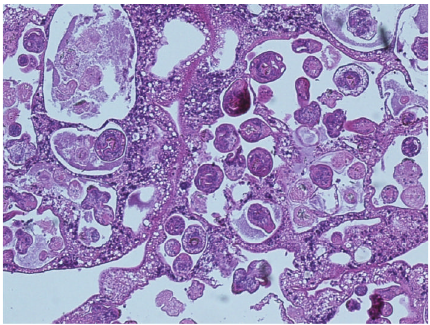
Figure 3: H&E stain of hydatid cyst contents demonstrating numerous scolices (with thanks to Dr. Faris Kubba, Consultant Histopathologist, Ealing Hospital NHS